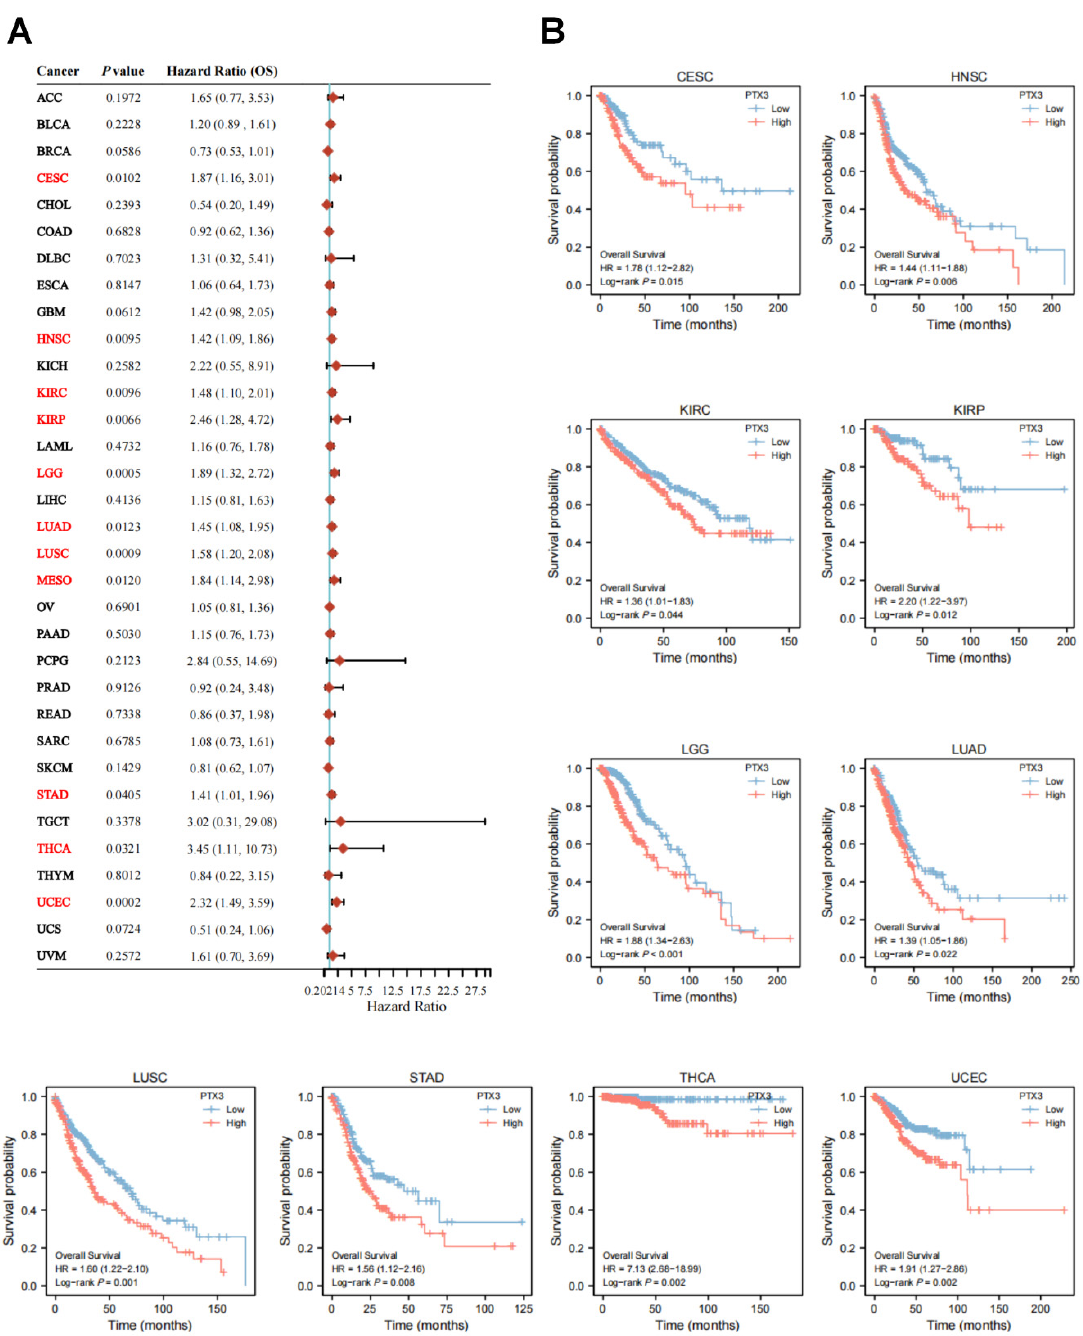
Figure 3. PTX3 expression with OS: ( A ) Forest plot showed univariate Cox regression analysis of PTX3 in pan-cancers (red color indicated statistical significance); ( B ) KM curves of the association between PTX3 expression and OS in cancers.